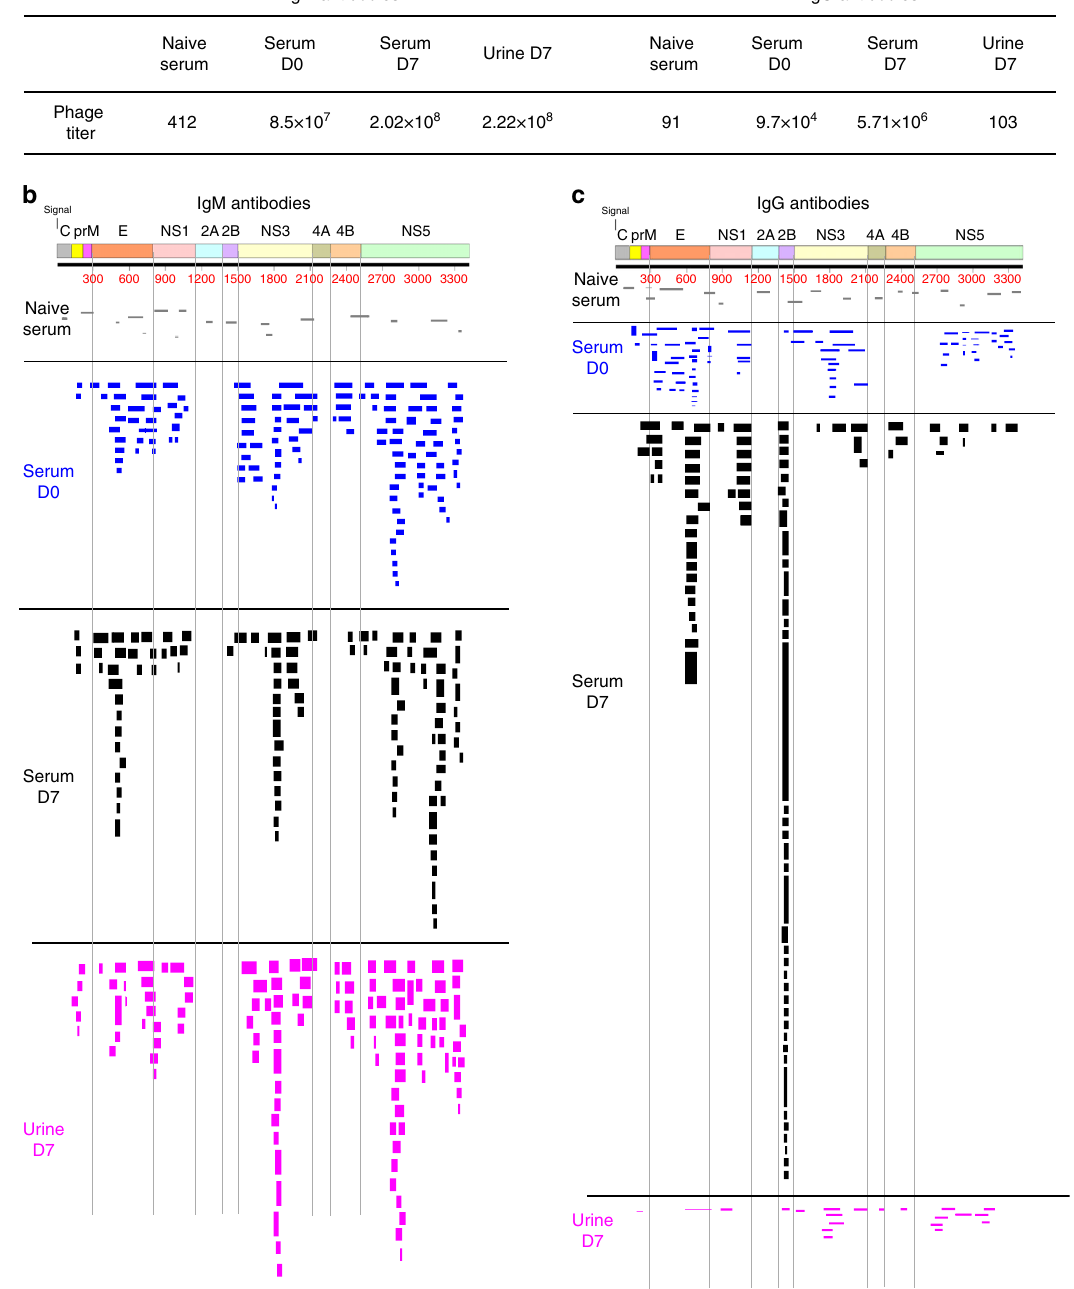
Fig. 1 IgG and IgM repertoires across Zika virus (ZIKV) proteome following Zika virus infection. a Number of bound phage clones isolated using ZIKV GFPDL af fi nity selection against fl avivirus naive negative control serum, pooled serum samples from fi ve acutely ZIKV-infected patients on day 0 and day 7 of hospital visit, and urine sample on day 7 of hospital visit (day 0 of hospital visit corresponds to 0 – 3 days since onset of symptoms for these fi ve patients). b , c Schematic alignment of the peptide sequences recognized by IgM ( b ) and IgG ( c ) antibodies in ZIKV-infected human sera (day 0 and day 7) and urine (day 7) and fl avivirus naive negative control serum, identi fi ed by panning with ZIKV-GFPDL. The amino-acid designation is based on the ZIKV polyprotein sequence encoded by the complete ZIKV-ICD genome (Supplementary Fig. 1). Bars indicate identi fi ed epitopes in the different structural (C, prM, E) and non-structural (NS) genes on the ZIKV polyprotein sequence. Graphical distribution of representative clones with a frequency of >2, obtained after af fi nity selection, are shown. The horizontal position and the length of the bars indicate the peptide sequence displayed on the selected phage clone to its homologous sequence in the ZIKV sequence on alignment. The thickness of each bar represents the frequency of repetitively isolated phages. Phage sequences and clonal frequency is shown in Supplementary Table